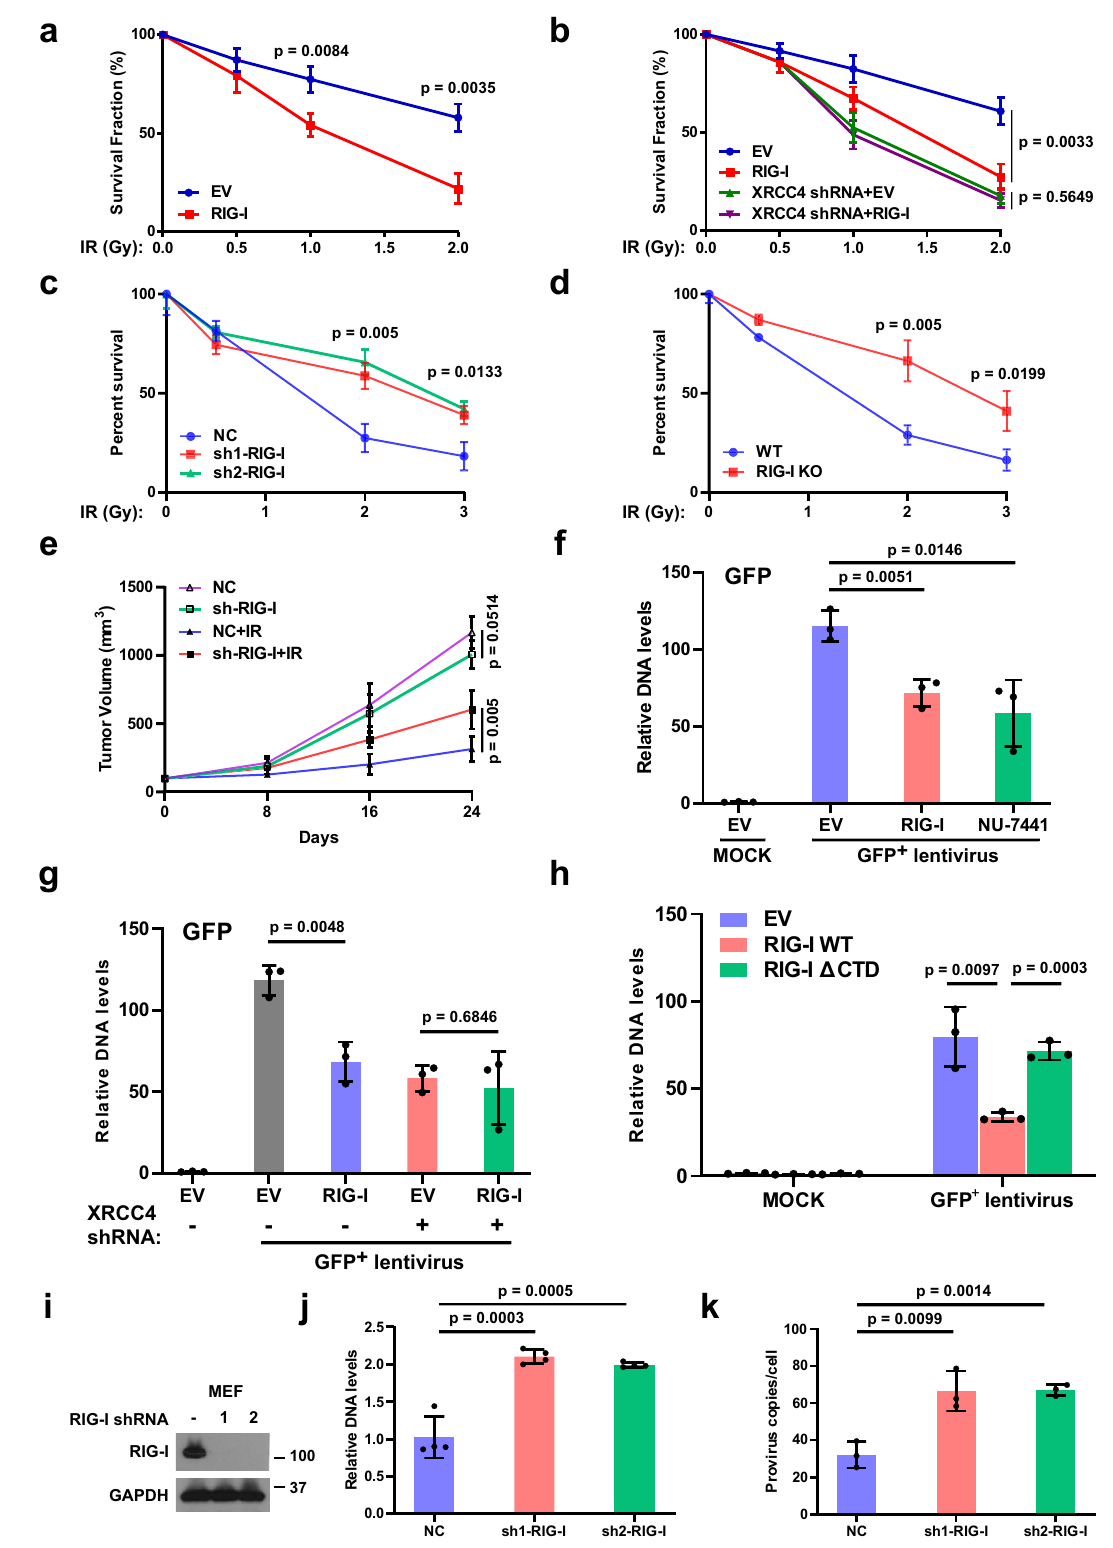
results demonstrate that XRCC4 coordinates with RIG-I to sup- press RNA virus replication by promoting ef fi cient production of type I IFN in host